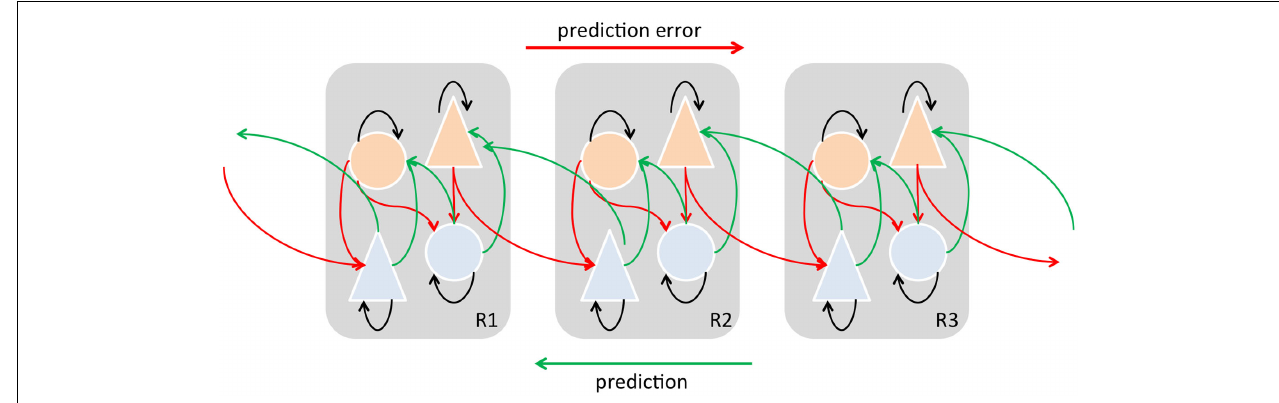
their targets, are associated with gamma-band oscillations, and are mediated by GABA and fast AMPA receptor kinetics. Conversely, feedback signals conveying predictions originate in deep layers and project to superficial layers, are associated with beta-band oscillations, and are mediated by slow NMDA receptor kinetics. Adapted from (Friston, 2009; see alsoWang,